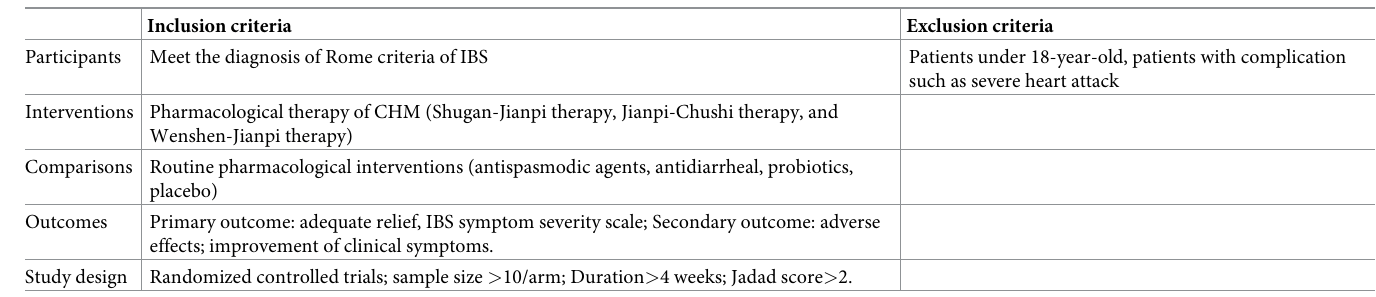
Table 1. Eligibility criteria